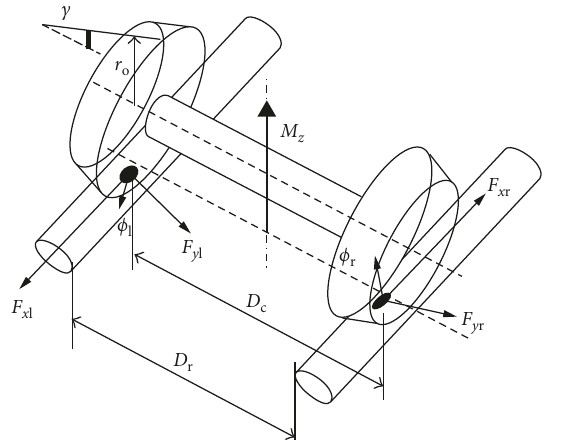
Figure 5: Schematic diagram of wheel rail contact.